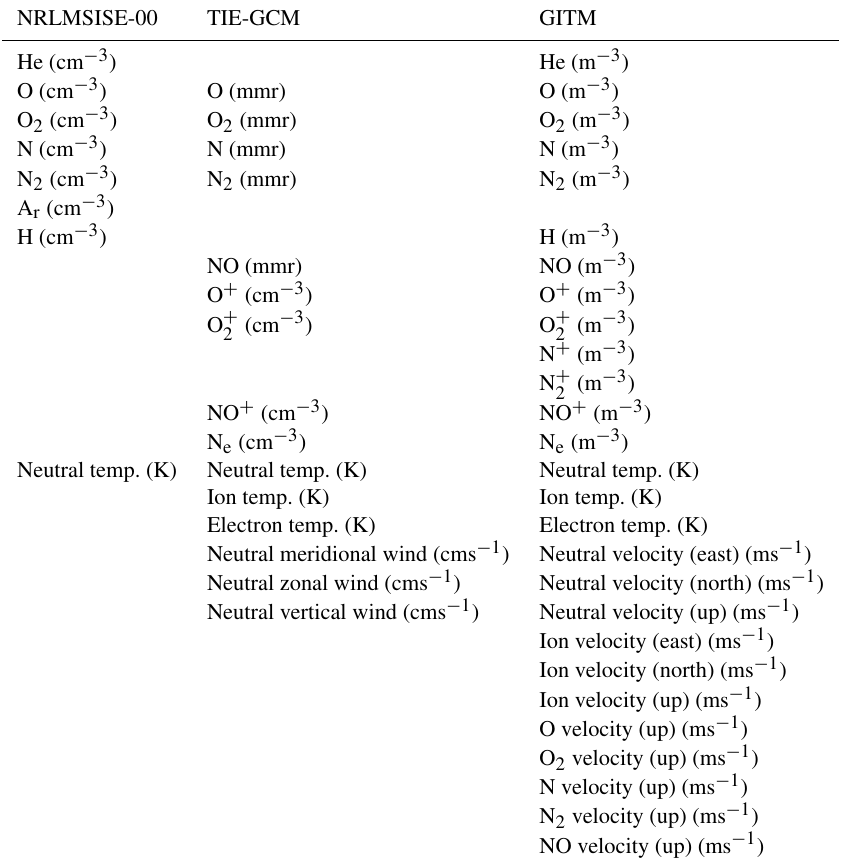
Table 3. NRLMSISE-00, TIE-GCM, and GITM model outputs. mmr is the mass mixing